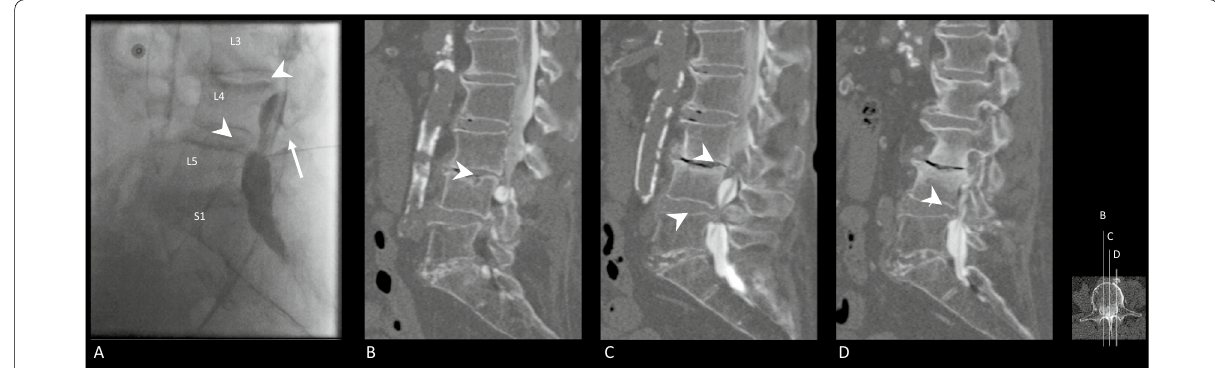
Fig. 4 Fluoroscopic myelography and CT myelography images after lumbar punction and intradural injection with iodine-contrast medium. A Fluoroscopic myelography image after lumbar punction. The lumbar punction needle is annotated by the white arrow. Iodine-contrast is inserted into intradural space and shows spinal stenosis (white arrowheads) at level L4–L5 and, to a lesser extent, at level L3–L4. B – D Sagittal reconstructions of CT myelography (localization as depicted by the axial miniature on the right-hand side). The injected iodine-contrast is observed as radiopaque fluid in the dural sac. These images confirmed the observed spinal stenosis at level L4–L5 and L3–L4 as observed on fluoroscopic myelography. Spinal stenoses are annotated by use of the white